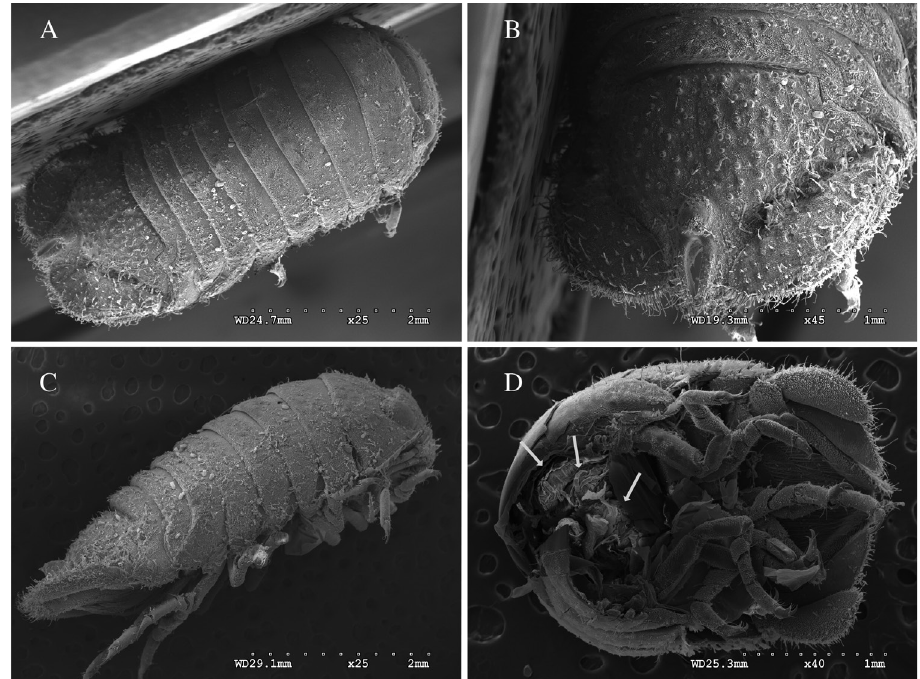
Figure 6. Dynoides elegans . ♀ , non-type. USNM 86407. A dorsal B pleotelson C lateral. ♀ , non-type. LACM-MBPC 17832 D posterior half of gravid individual with mancas and ventral view of